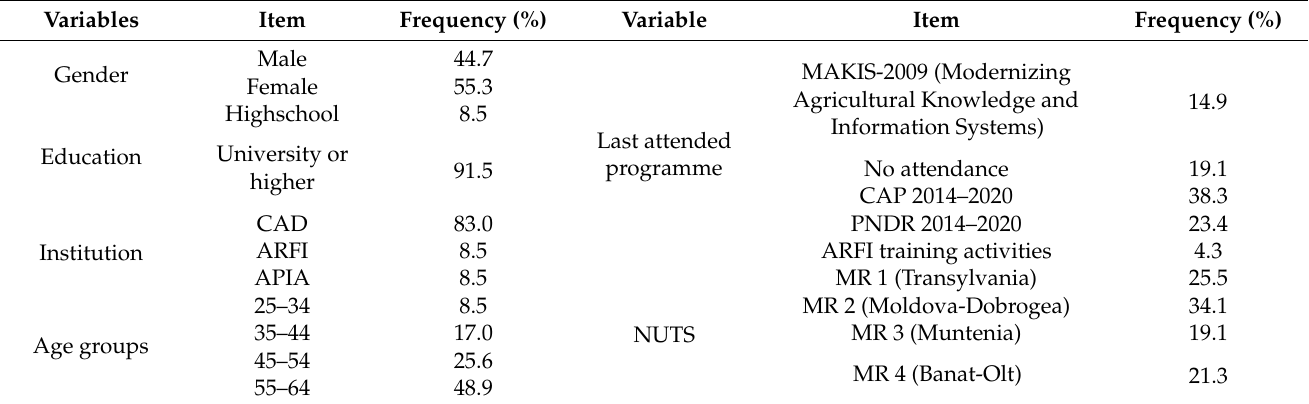
Table 4. Socio-demographic profiles of civil servants with agricultural